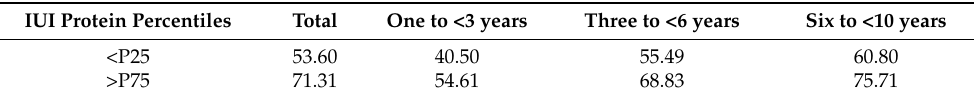
Table 5. Calculated protein cutoff points for the Nutritional Study in the Spanish Pediatric Population (EsNuPI) (g/d). IUI Protein Percentiles